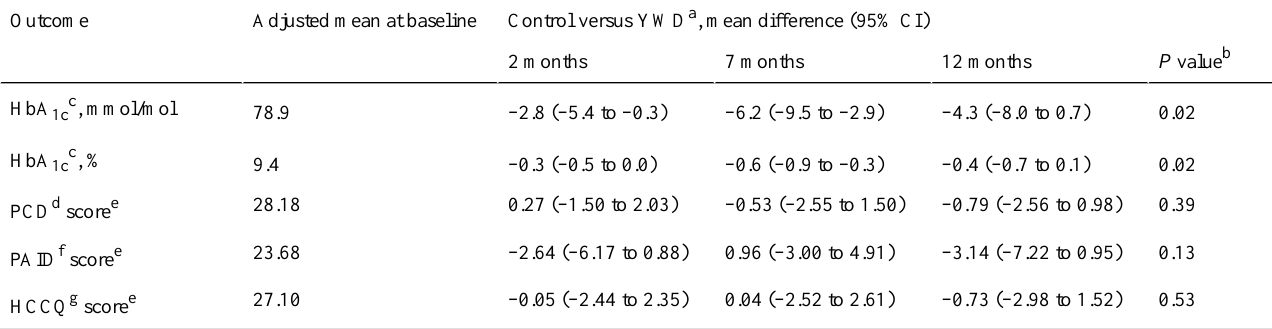
Table 2. Between-group differences in